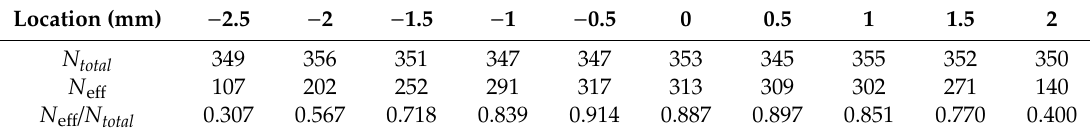
Table 1. Number and ratio of the e ff ective bubbles to total detected